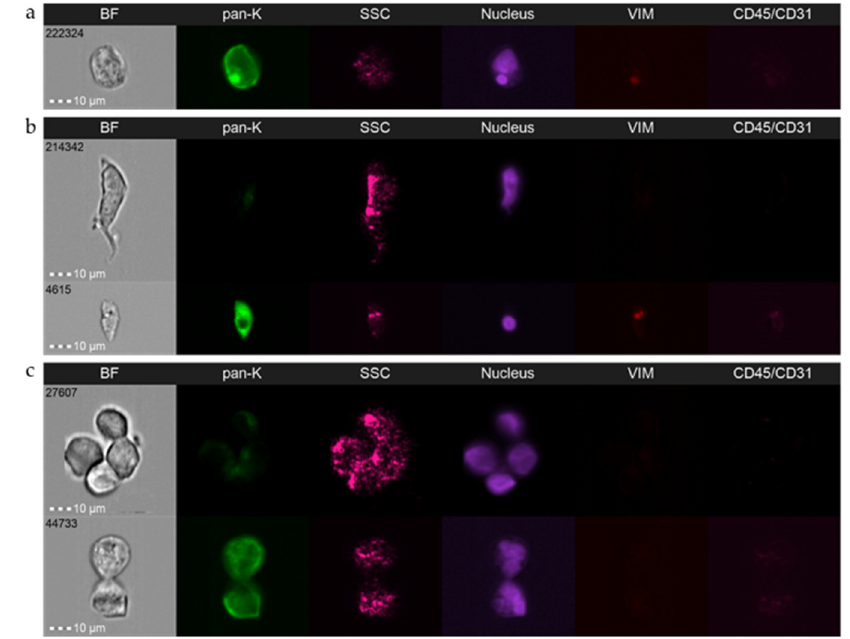
Figure 3. Representative pictures of CTC’s morphological details envisioned by imaging flow cytometry: ( a ) presence of micronucleus; ( b ) cell protrusions; ( c ) clusters stereometry. Amnis ® ImageStream ® X Mk II (Luminex, Austin, TX, USA), objective 40×.